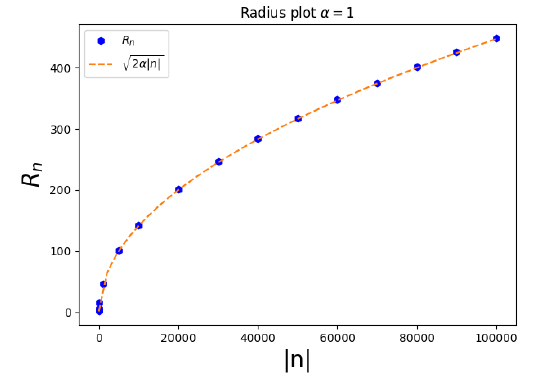
p 2 (cid:22) j n j . We